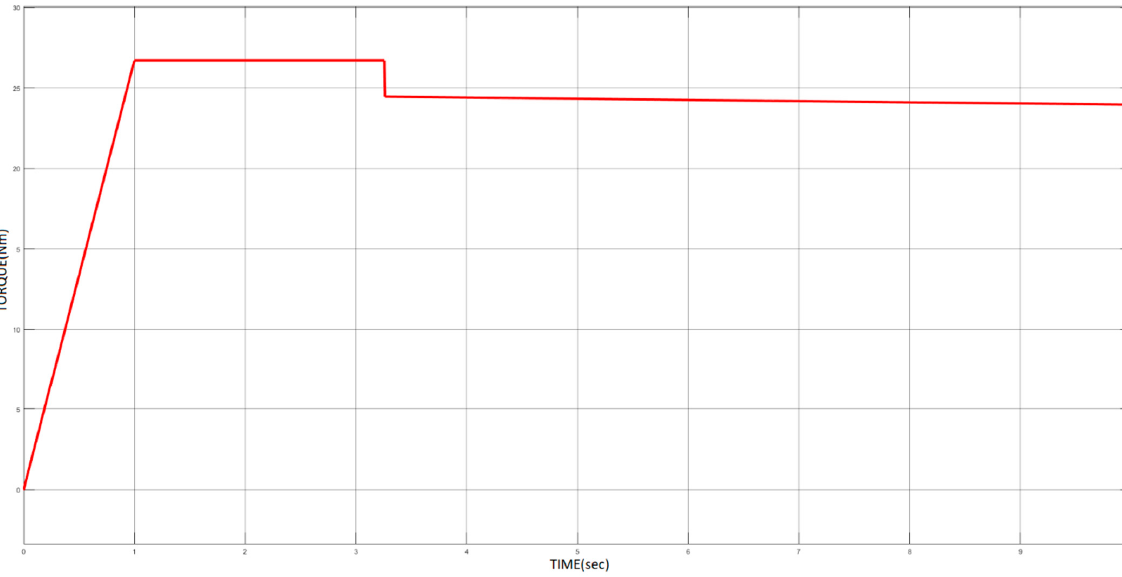
Figure 7. Ramp load toque of IM.